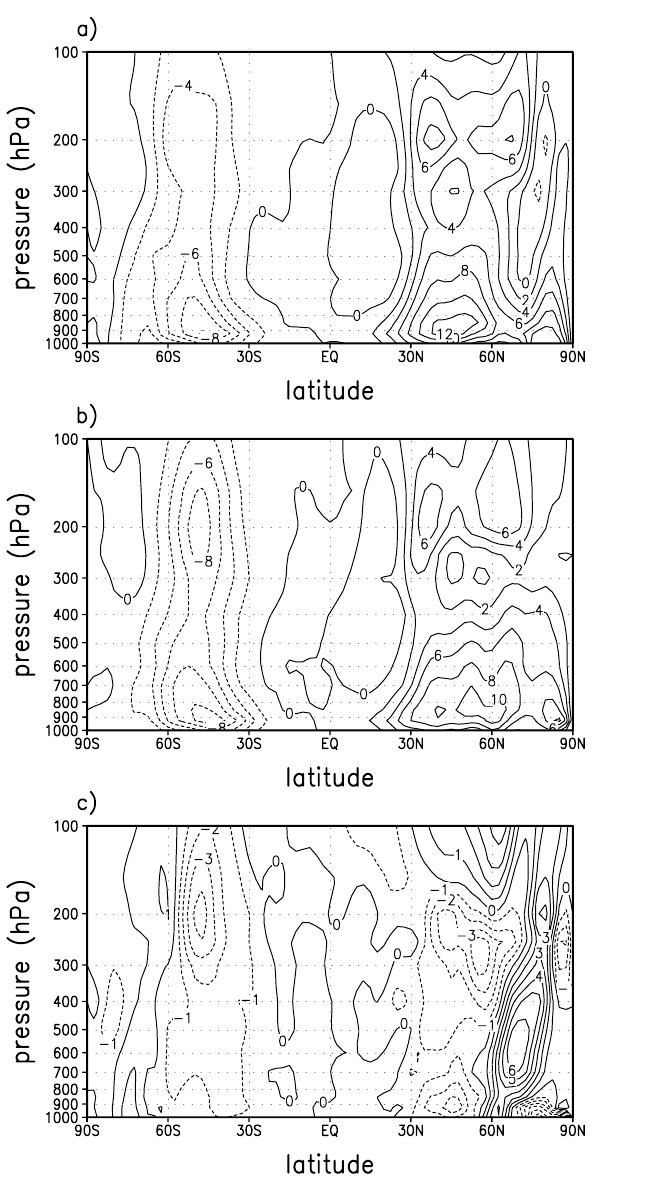
Fig. 7. Zonally-averaged eddy momentum flux for January: (a) 1996, (b) 1998, and (c) Difference (1998 minus 1996). Units, m 2 s − 2